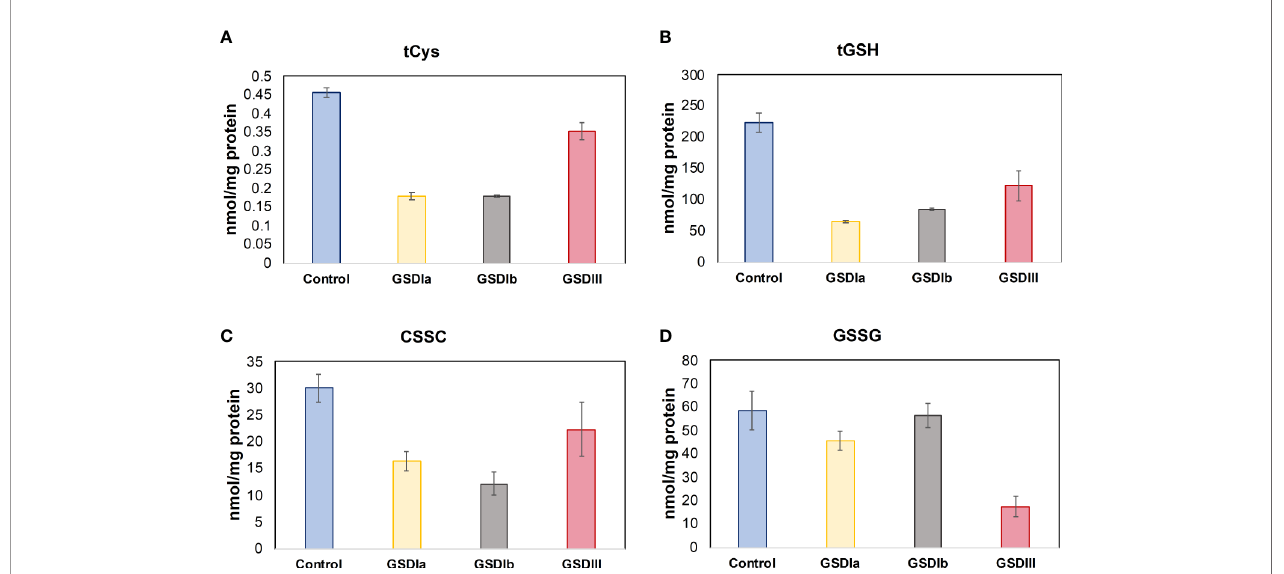
reminisces futile redox cycling, i.e. electron leakage from the and content of mitochondria in GSD appeared to be intact under our experimental conditions and there were no changes in basal oxygen consumption rates, our metabolite patterns recapitulate